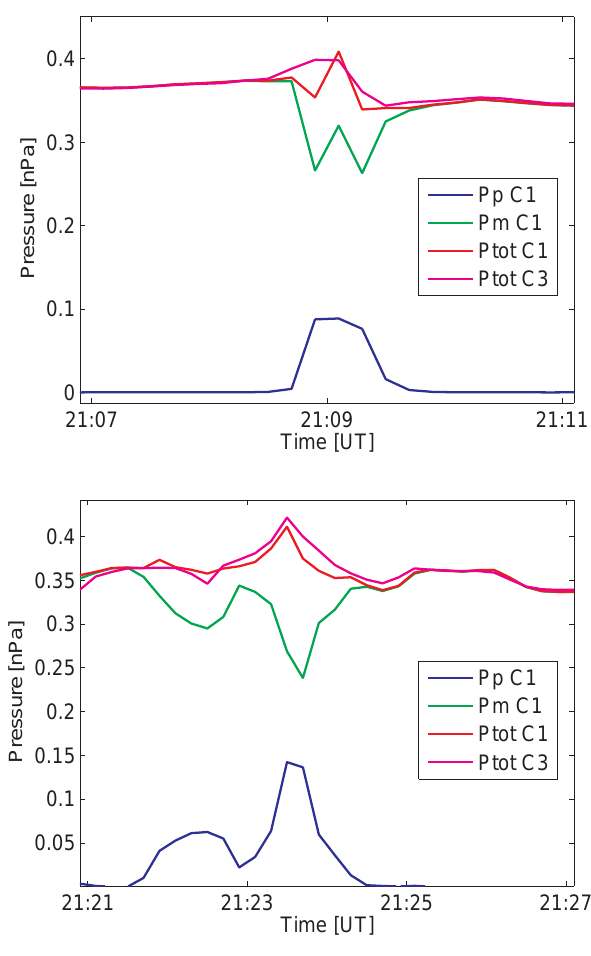
Fig. 11. During TCR2 (upper panel) and TCR3 (lower panel) space- craft C1 was located inside the plasma flow and C3 outside the flow. The total pressure inside the outflow region (red), composed of the plasma pressure (blue) and the magnetic pressure (green) corre- sponds well with the total pressure outside the outflow region (ma-